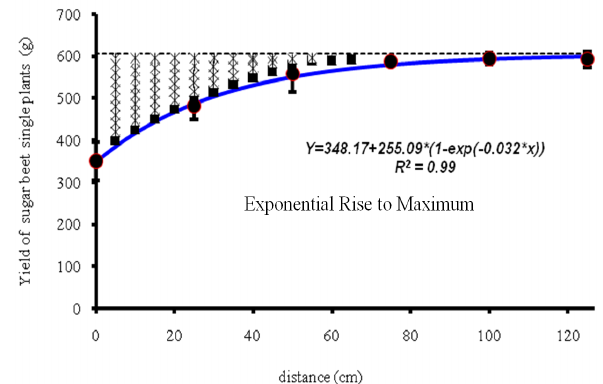
Fig. 2. Neighbor effect of ground cherry upon yield of sugar, the higher the sugar beet distance from single weed, the higher the yield